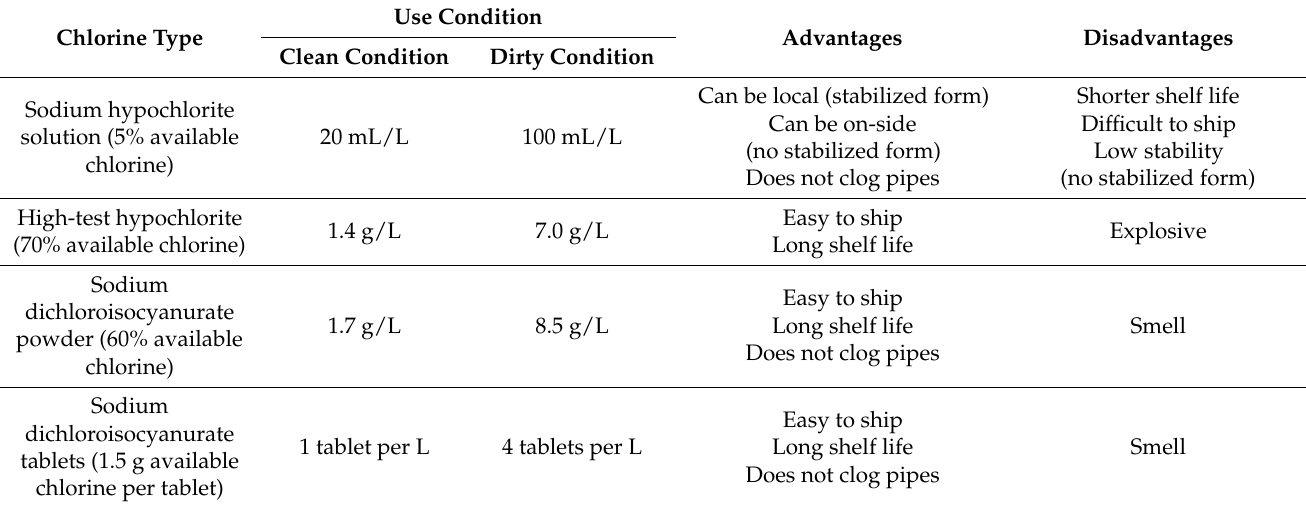
Table 4. Recommended dilutions of commonly used chlorine releasing compounds.